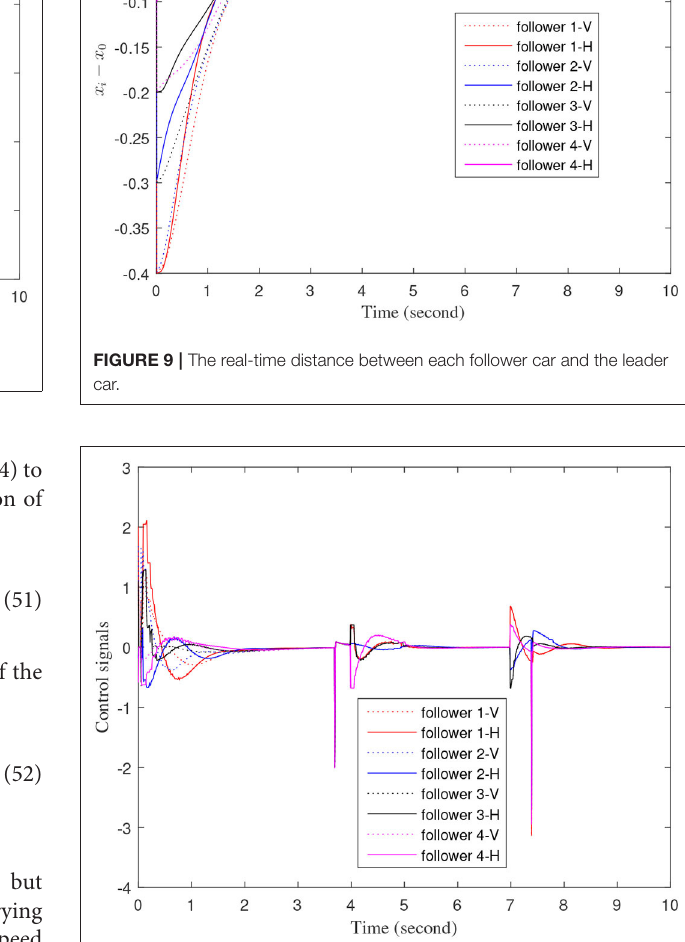
FIGURE 10 | Control input signals of each follower